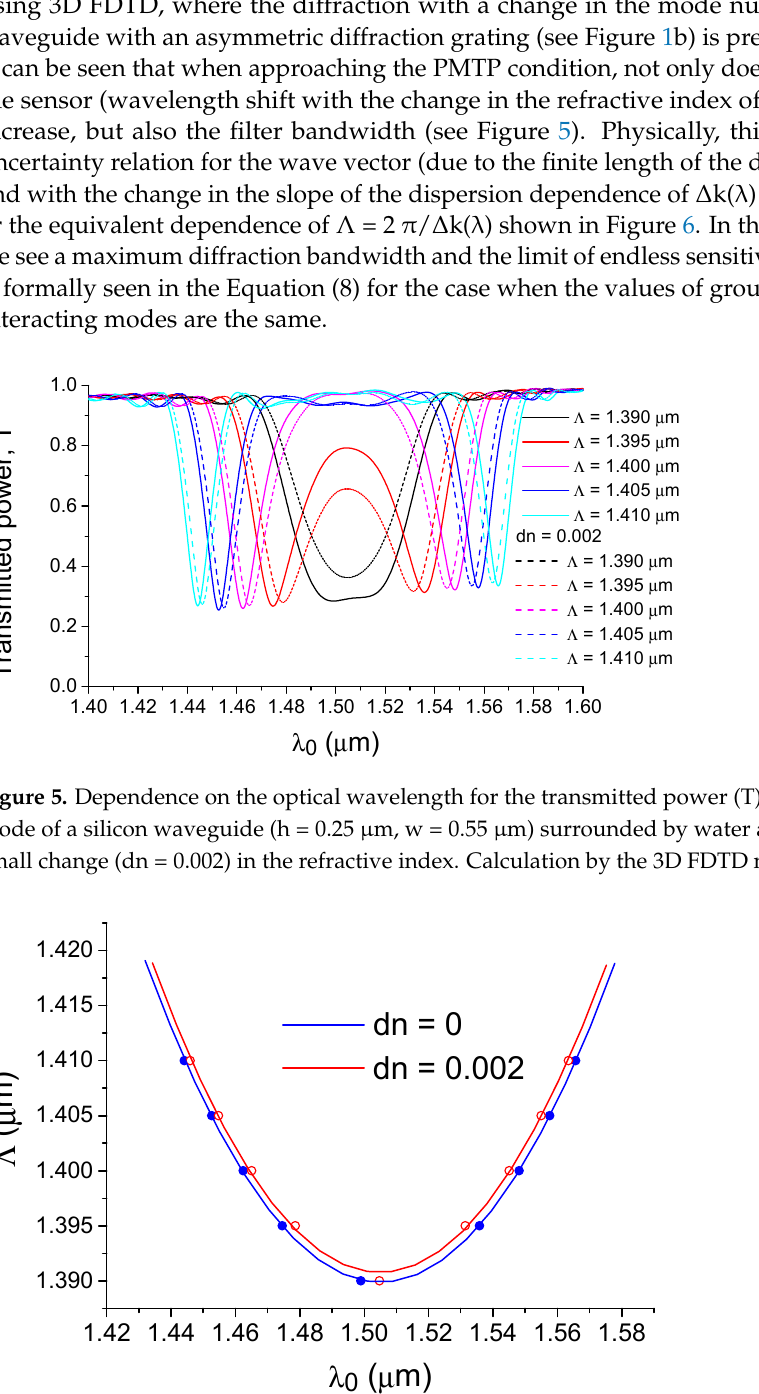
Figure 6. Dependence of the diffraction grating period on the optical wavelength for which Bragg diffraction occurs from the TE 0 mode to the TE 1 mode. The structure is surrounded by distilled water and for water with a small change (dn = 0.002) of the refractive index. Calculation by the 3D FDTD method.